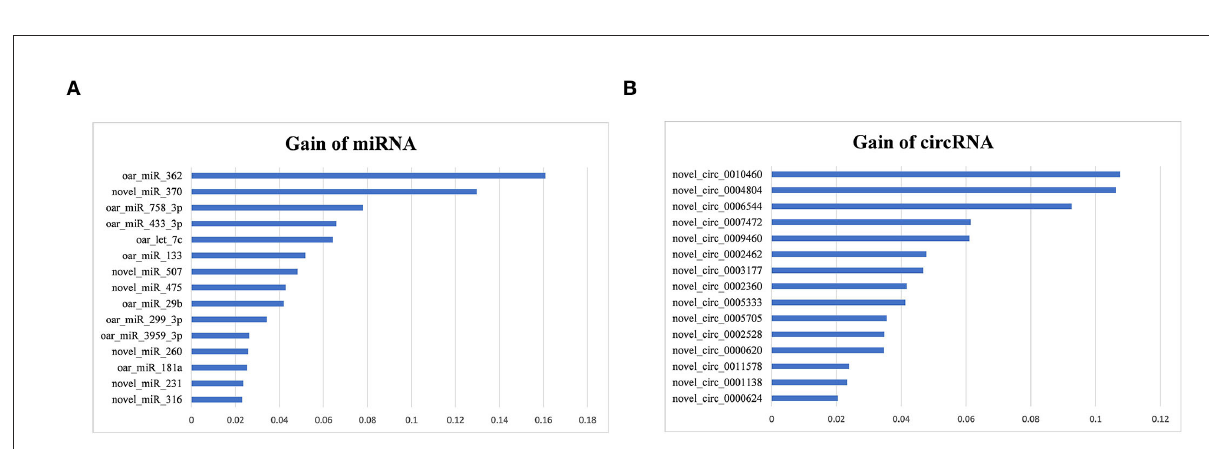
FIGURE8 Gain values of the top miRNA (A) and circRNA (B) biomarkers of sheep lactation identified.